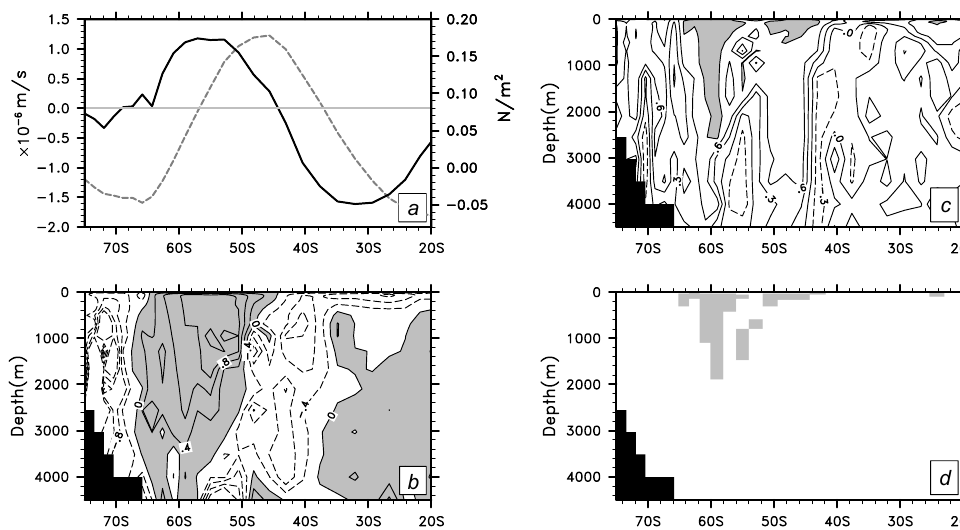
Figure 3. ( a ) The meridional distribution of the zonal mean zonal wind stress ( τ x ) (gray, dashed line) and zonal mean Ekman pumping w Ek (black, solid line) averaged over the last 22,000 years. ( b ) The depth–latitude diagram of the correlation between w Ek and zonal mean vertical velocity w in the last 22,000 years. At each latitude, the simultaneous correlation coefficient is calculated between w Ek and w on each depth. Gray shading areas denote where the correlation coefficient is higher than 0.9. ( c ) The depth–latitude diagram of w (contour in 10 − 6 m/s) averaged over the last 22,000 years. Gray shading areas show where w is positive. ( d ) The depth–latitude diagram in which gray shading areas denote where w Ek is approximately equal to w by satisfying two conditions: (1) the correlation coefficient between w Ek and w is higher than 0.9; and (2) the difference between w Ek and w is smaller than 10 − 6 m/s (about 10% of maximum w Ek